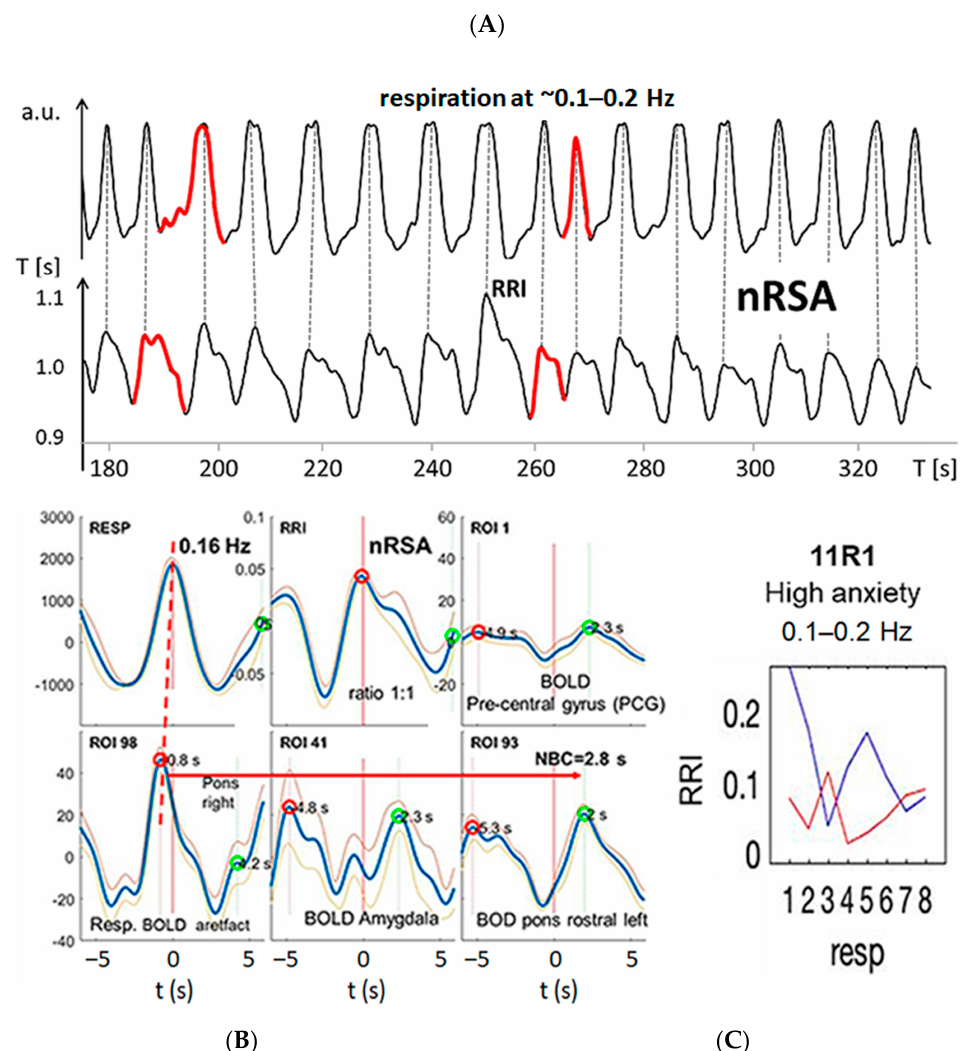
Figure 3. Example from subject #11. ( A ) Records of respiratory (upper trace) and RRI waves (lower trace); abscissa: time [s]. Some respiratory and RRI periods with PD transitions are marked in red. Note that transitions in the RRI rhythm precede changes in the respiratory rhythm by one period. ( B ) RRI peak (longest RR interval)-triggered respiratory (resp), RRI and BOLD waves from the PCG, pons and amygdala (blue and gray lines: mean ± SEM). The red and green circles have been automatically inserted by the computer program and mark local maxima on the negative and positive time scale, respectively. The coherence of respiratory and RRI waves indicates nRSA (upper line, left and middle panels). The vascular BOLD artefact in the right pons (lower line, left panel) slightly precedes respiration (red stippled line). The red horizontal arrow indicates the neural-BOLD coupling time (NBC) between the vessel motion artefact and the neural BOLD component. Note the non-sinusoidal oscillation in the amygdala (lower line, middle panel). ( C ) Information flow between RRI and respiration, blue lines indicate flow from respiration to RRI, red lines indicate flow from RRI to respiration. The numbers 1–8 on the abscissas represent consecutive time windows of the